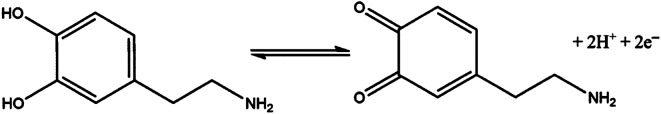
The redox reaction of dopamine to/from dopamine-o-quinone.